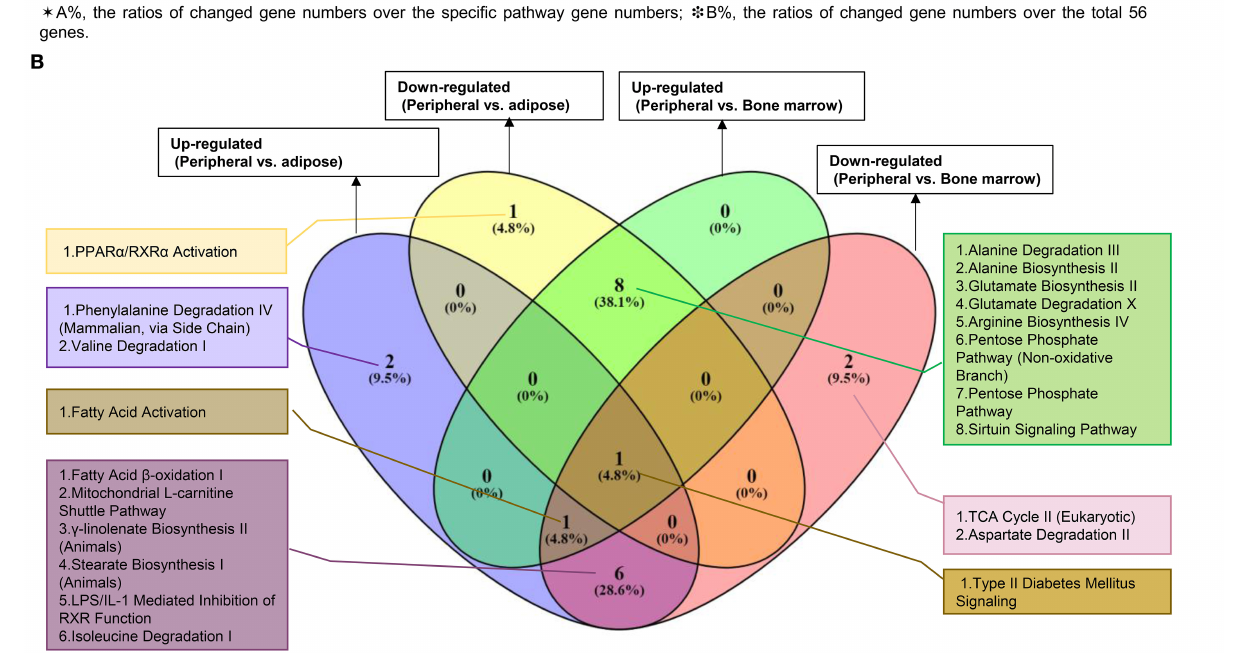
FIGURE 5 | (A) Mechanism V: The macrophages from peritoneum, lung, liver, and spleen upregulate more bioenergetics pathway enzymes (immunometabolism pathway) than adipose tissues, with a significantly increased pentose phosphate pathway, three significantly increased fatty acid-related pathways, and a decreased glutamine pathway, and the macrophages from bone marrow express higher bioenergetics pathway enzymes than peritoneum, intestine, and adipose tissues (For detailed expression data, see Figure S7 ). (B) Ingenuity Pathway Analysis of bioenergetics/immunometabolism pathway